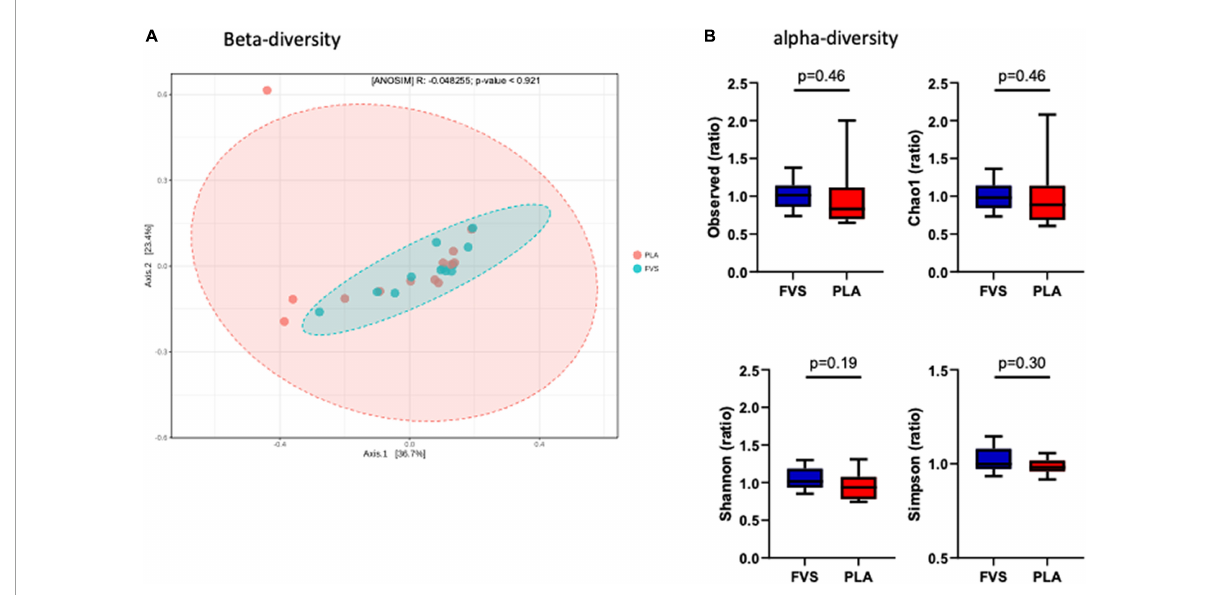
FIGURE2 Gut microbial diversity in the FVS and PLA groups. (A) Beta diversity index was measured by using the Bray–Curtis method using principle coordinate analysis (PCoA) using the relative abundance of OTUs. The two variances explained by Axis.1 and Axis.2 are 36.7 and 23.4%, respectively. ANOSIM, analysis of similarity was not significant ( p = 0.921). (B) Alpha diversity was measured by the four commonly used methods, such as observed, Chao1, Shannon, and Simpson methods. The box plots show interquartile (IQR) ranges with the median and whiskers. FVS, N = 15, PLA, N = 14. p < 0.05 considered statistically significant using Student’s t-